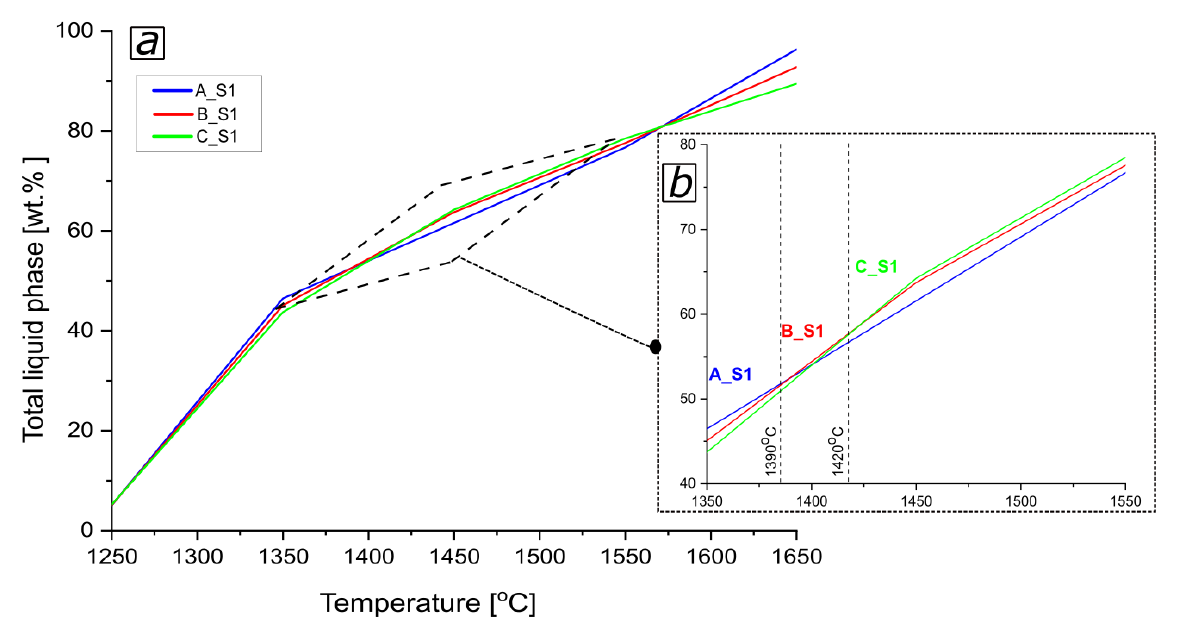
Figure 9. ( a ) The total liquid phase content in castables composition (A, B, and C) with slag (S1) [wt.%] vs. temperature, ( b ) insert figure to a lesser extent.